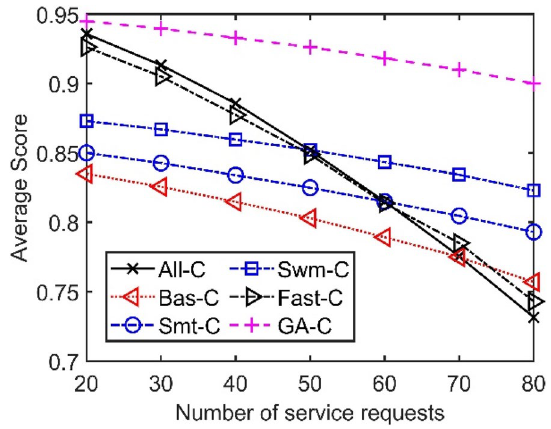
Fig. 11 Average score of different